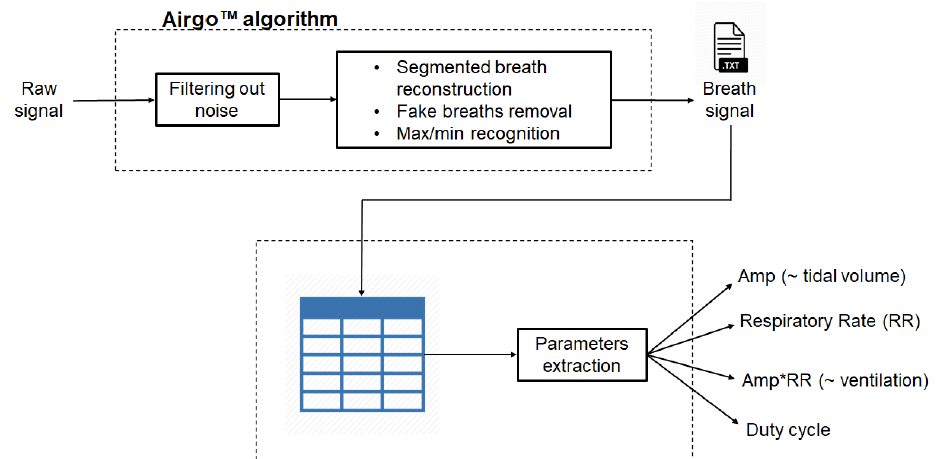
Figure 5. Box scheme of the raw signal processing and extraction process of the parameters of interest: amplitude (Amp), which represents Airgo™’s signal variation and models SensorMedics’ tidal volume; respiratory rate (RR); Airgo™’s minute ventilation (Amp×RR), which models SensorMedics’ minute ventilation; duty cycle, which is the ratio between inspiratory time and total breath period.